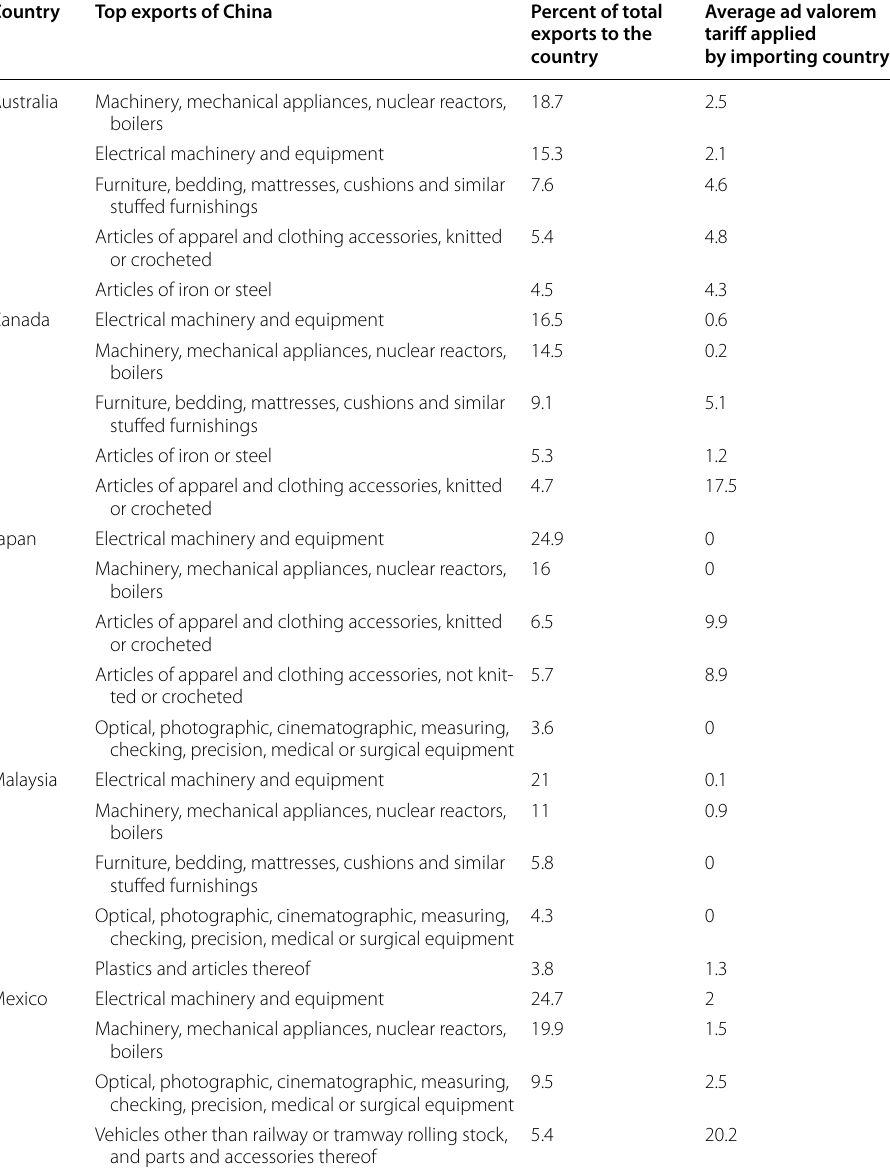
Table 4 China’s top exports to its top export markets in TPP region (2015) Country Top exports of China Percent of total